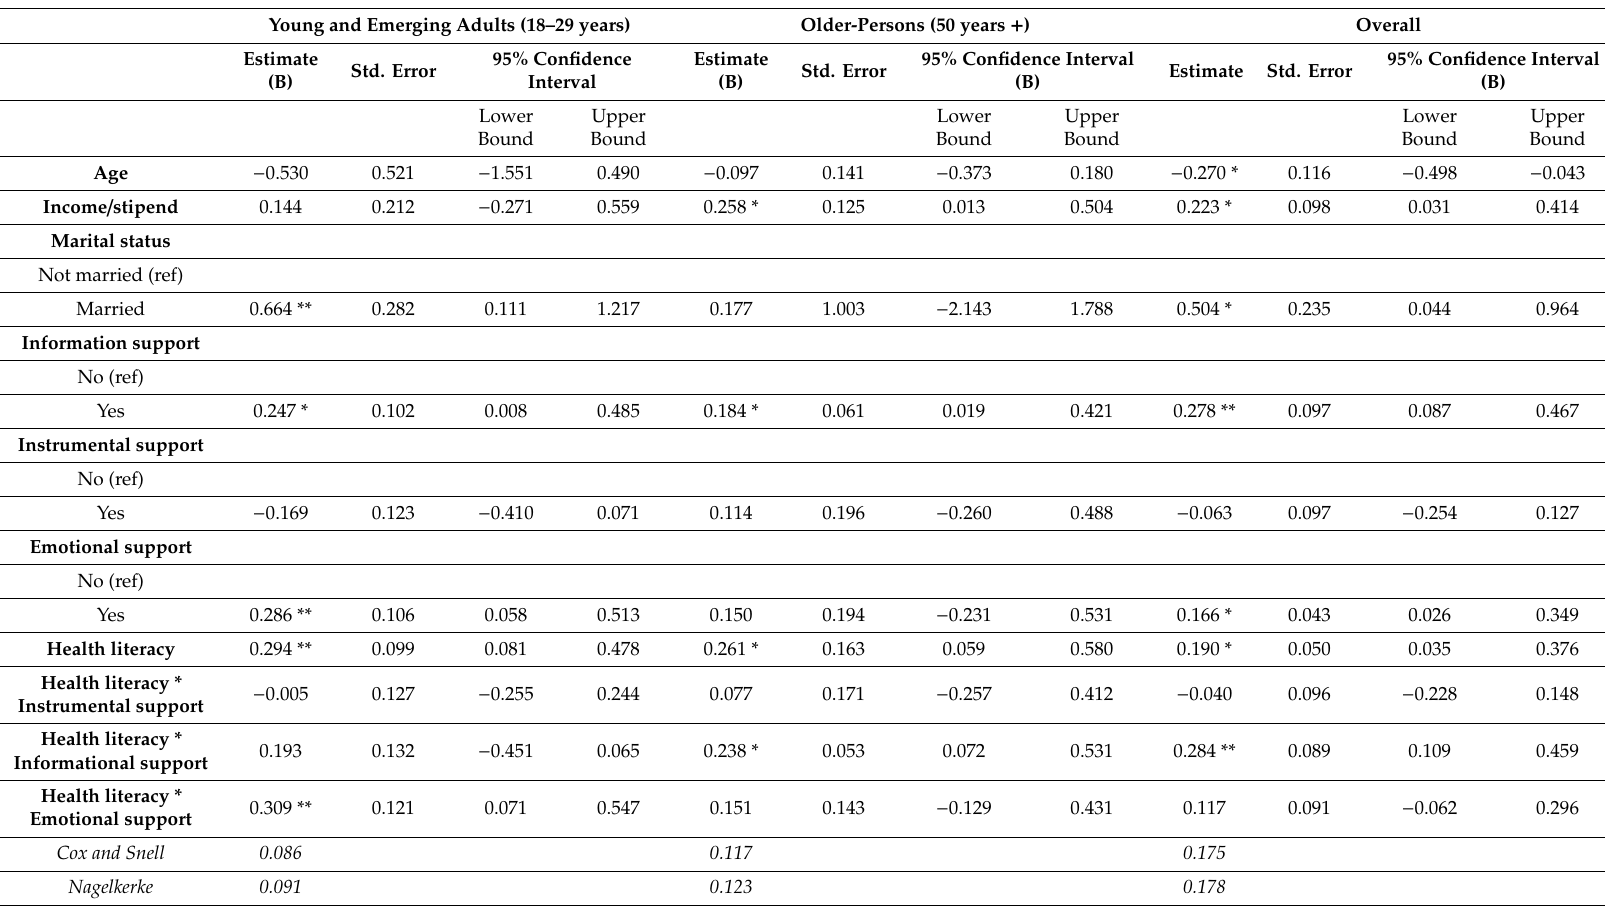
Table 2. The relationship between social support proxies and health literacy and health status by ordinal logistic regression b . Young and Emerging Adults (18–29 years) Older-Persons (50 years + ) Overall Estimate 95% Confidence Estimate 95% Confidence Interval Std. Error Std. Error Estimate Std. Error (B) Interval (B) (B) Upper Lower Upper Bound Bound Bound